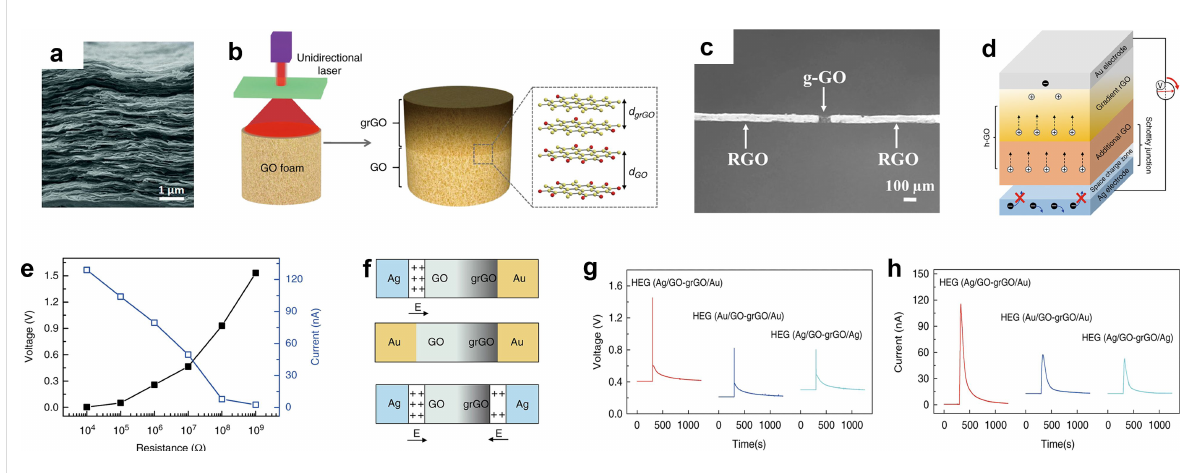
Figure 5: (a) Cross-sectional SEM image of GO’s nanoscale network structure. Figure 5a was republished with permission of The Royal Society of Chemistry from [63] (“Electric power generation via asymmetric moisturizing of graphene oxide for flexible, printable and portable electronics” by Y. Liang et al., Energy Environ. Sci., vol. 11, issue 7, © 2018); permission conveyed through Copyright Clearance Center, Inc. This content is not subject to CC BY 4.0. (b) Schematic diagram of the structure of vertically oriented asymmetric graphene. (c) Image of laser-processed